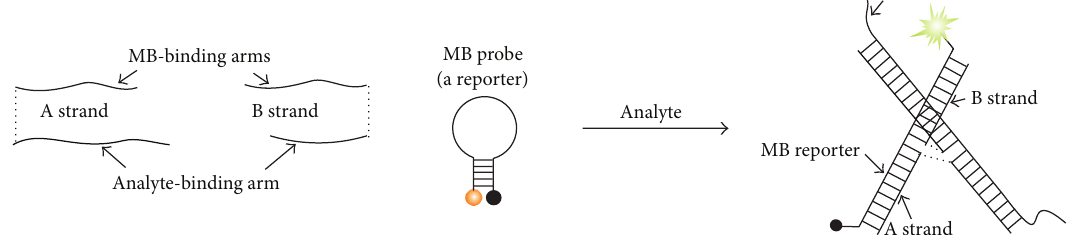
F 6: �sing a universal MB (�MB) probe as a part of tricomponent X sensor for recognition of speci�c DNA or �NA sequences [98, 108]. Adaptor and strands hybridize to both analyzed sequence and a universal near-optimal MB probe reporter to form �uorescent tetrapartite complex. Triethylene glycol linkers (TEG) that connect the MB-binding arms with the analyte-binding arms are shown as dashed lines. 𝐴𝐴 𝐵𝐵